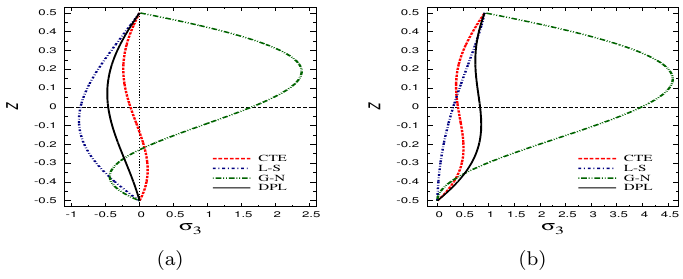
Figure 11. The transverse normal stress distributions in the thickness direction for beams under (a) thermal load and (b) thermomechanical load.